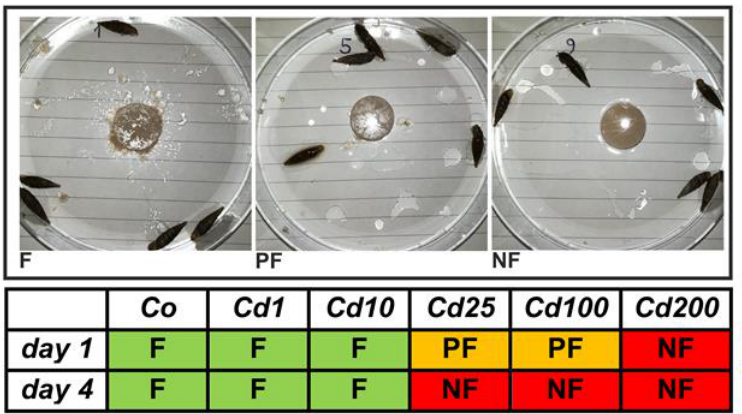
Figure 2. Feeding behavior of A. biplicata in control snails and individuals fed on Cd-contaminated cookies. The photographs illustrate the three categories of feeding (F), poor feeding (PF), and non-feeding (NF) in control (Co) and Cd-exposed snails (Cd1, Cd10, Cd25, Cd100, and Cd200) (for exact definition of feeding groups, see text). Cd exposure groups were defined as shown in the legend of Figure 1.